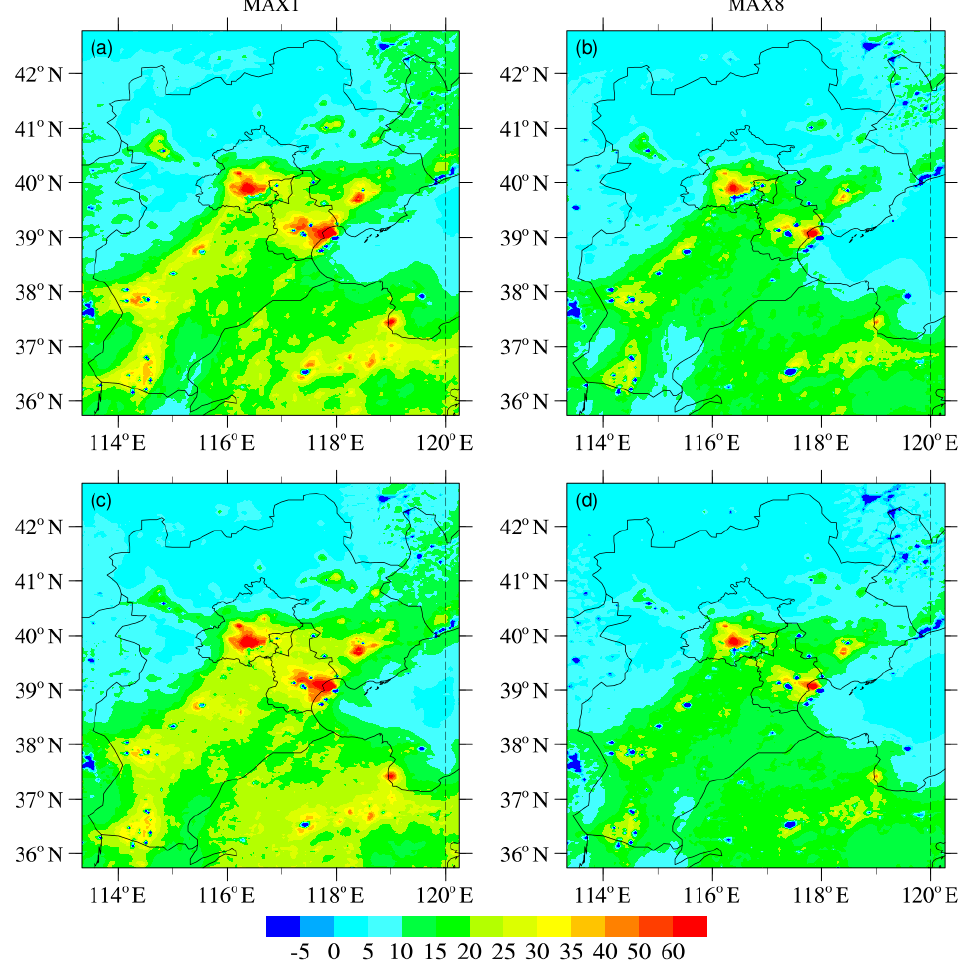
Figure 12. Monthly average distribution of photochemical net O 3 production (in µ g / m 3 ) in June and August 2017 over the NCP; ( a , b ) represent the maximum 1 h and maximum 8 h net generation in July; ( c , d ) represent the maximum 1 h and maximum 8 h net production in August.